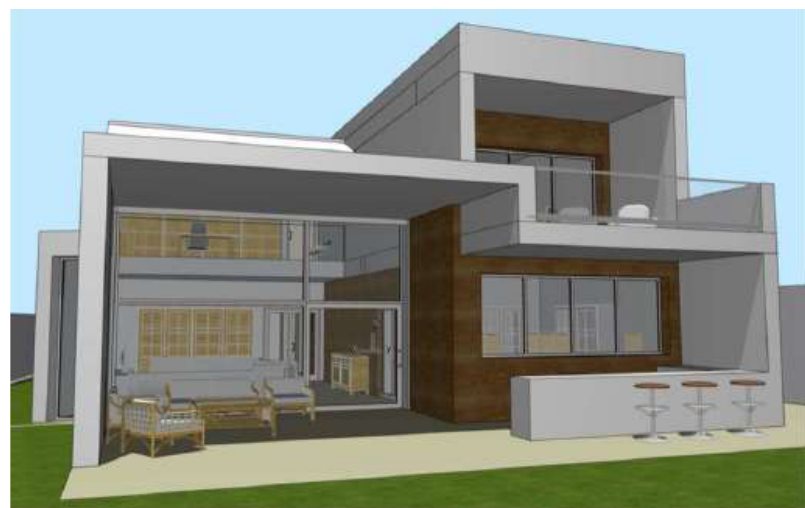
Figure 10. South elevation. Study sunlight June 21 at 2:00 p.m.